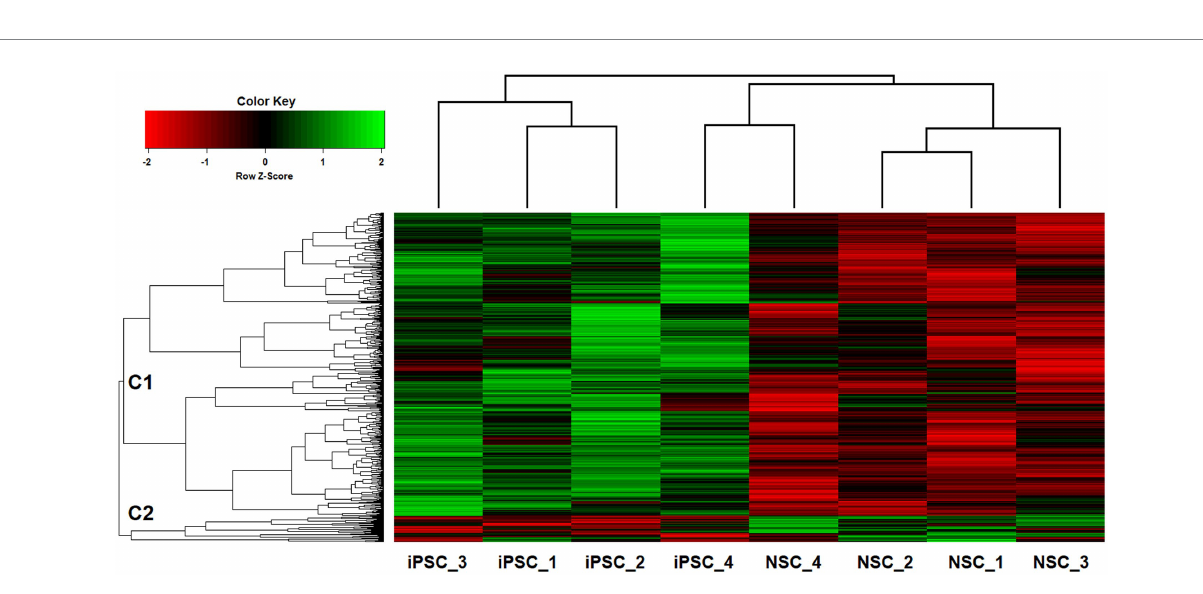
FIGURE 4 Two-way UPGMA clustering of VOOM-adjusted 5hmC expression levels for top iPSC-NSC differentiated sites ( p < 0.01; n = 701), with aligned heatmap of Z -scores (columns represent different iPSC and NSC cell lines; rows represent genome-wide